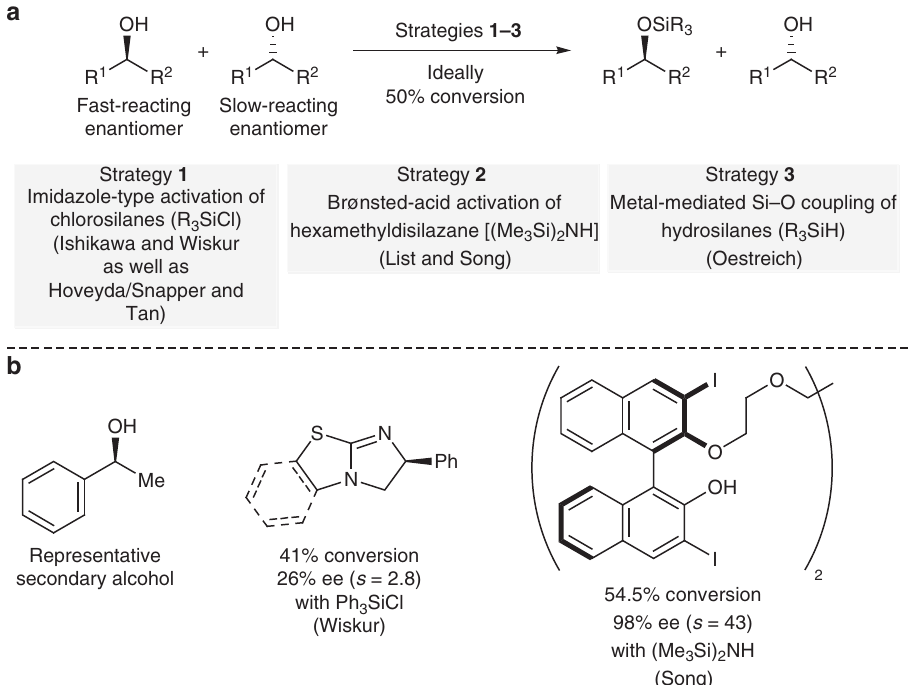
Figure 1 | Kinetic resolution of alcohols through silylation. ( a ) General equation and known strategies. ( b ) Representative substrate and reported catalysts. s , selectivity